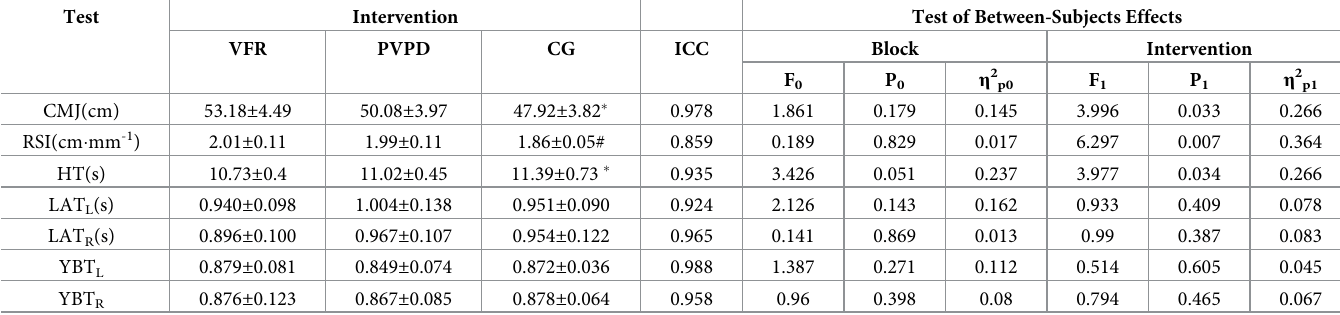
Table 1. Descriptive results of